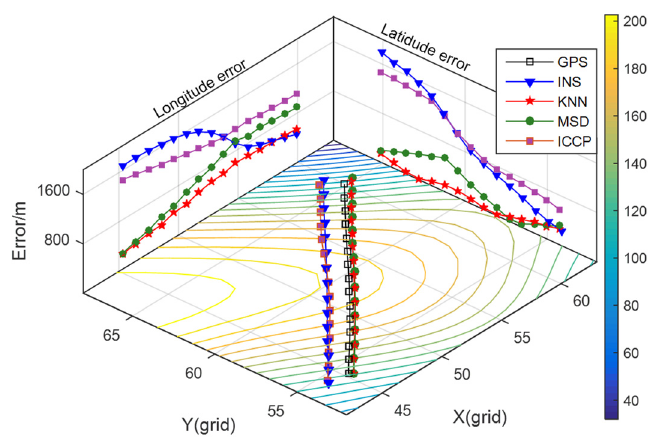
Figure 8. Matching results of track 2. Table 4. Statistics of positioning errors of track 2/m.